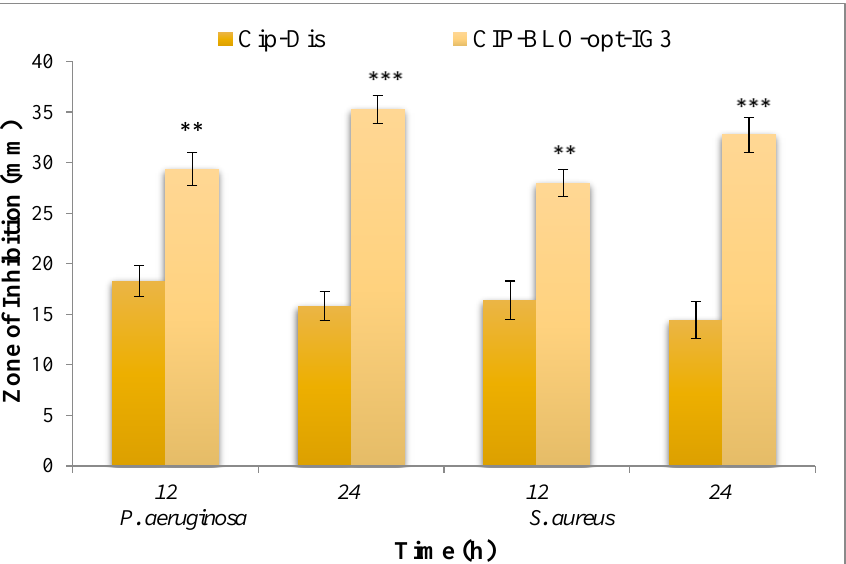
Figure 8. Antimicrobial graph of CIP-BLO-opt-IG3 and CIP dispersion against P. aeruginosa and S. aureus in the terms of zone of inhibition (ZOI). data are stated as mean ± SD, n = 3, **, and *** indicating that CIP-BLO-opt-IG3 is significantly different at 0.05 and 0.01, respectively, from pure CIP.